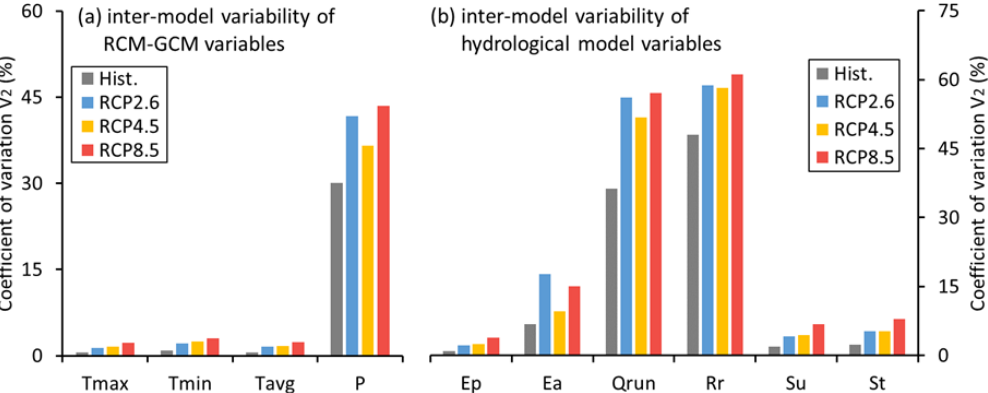
Figure 8. Average inter-model (i.e. RCM–GCMs) variability expressed with the second-order coefficient of variation ( V 2 ) for monthly hydroclimatic variables ( T max , T min , T avg , P , E p , E a , Q run , R r , S u , and S t ) over the historical period (1991–2020) and the future period (2021–2100) under various RCPs.